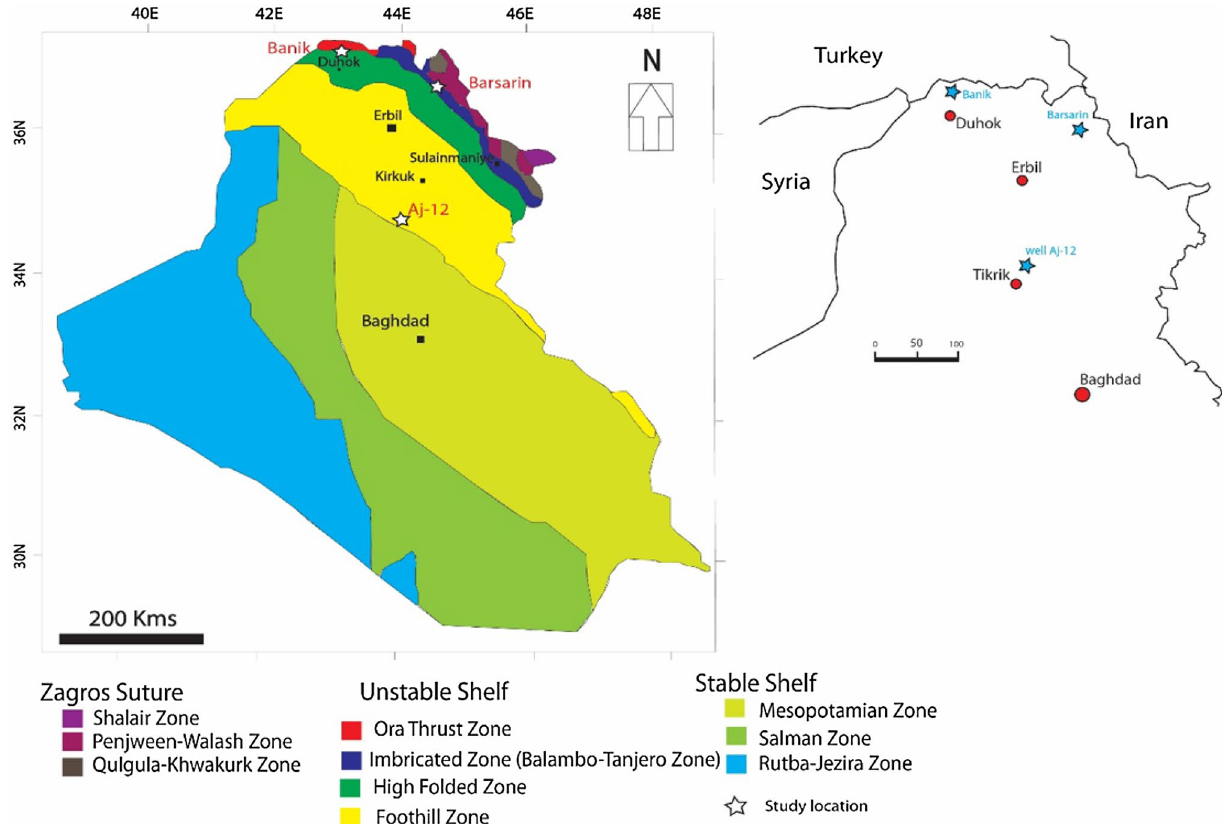
Fig. 1 Location and tectonic map of the study areas (Tectonic map is modified from Numan (2000), Jassim and Buday (2006), studied area map is modified from Google Earth